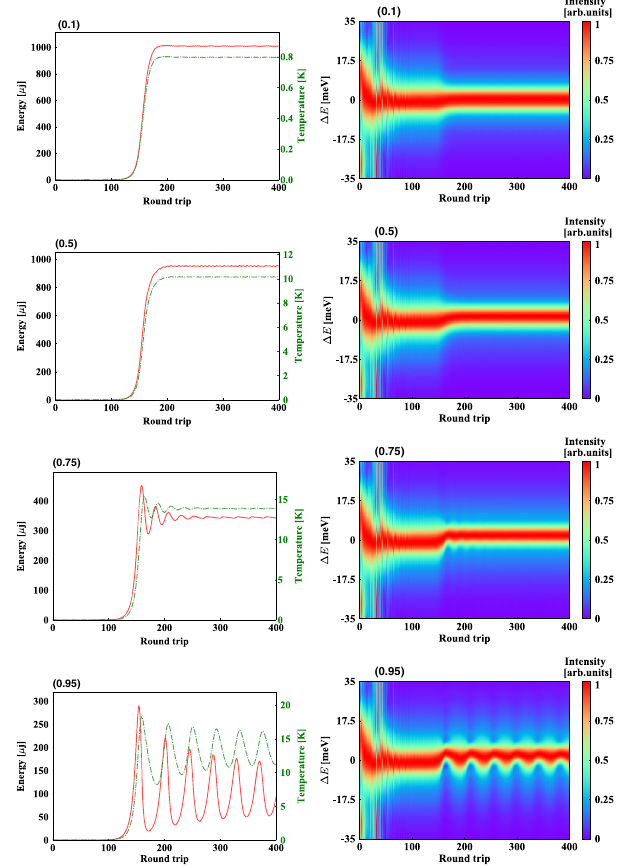
FIG. 13. The evolution of the pulse energy (red line) and the averaged temperature (minus 70 K, green line) at various η : 0.1, 0.5, 0.75, and 0.95. The evolution of the spectrum at various η : 0.1, 0.5, 0.75, and 0.95. In each round trip, the spectrum is normalized by its maximum